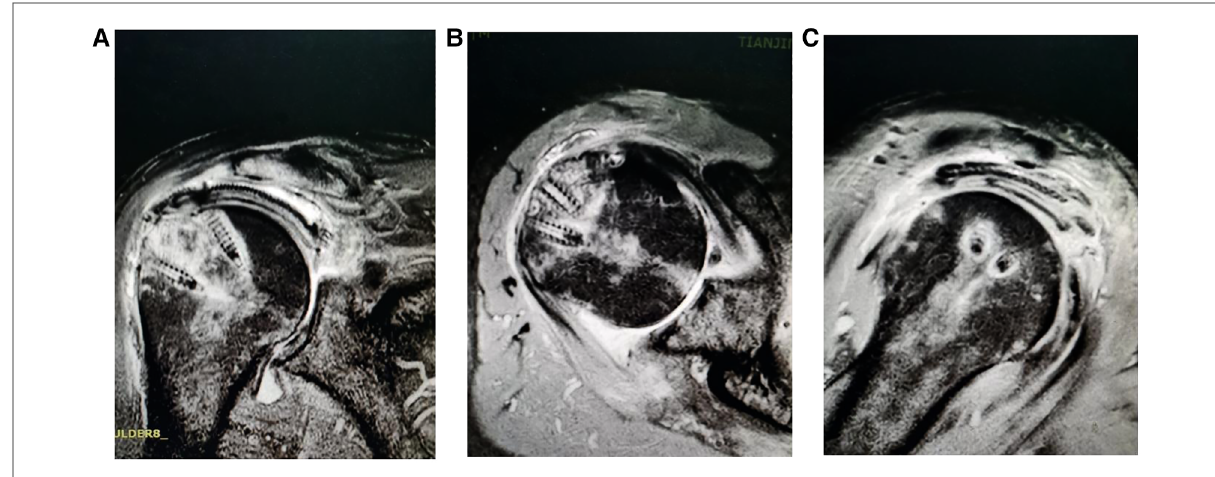
FIGURE 5 Postoperative radiograph of arthroscopic superior capsule reconstruction (20 months). ( A, B ) The fascia lata lateral side is fi xed to the rotator cuff footprints on the greater tuberosity using double row fi xation and ( C ) a completely healed fascia